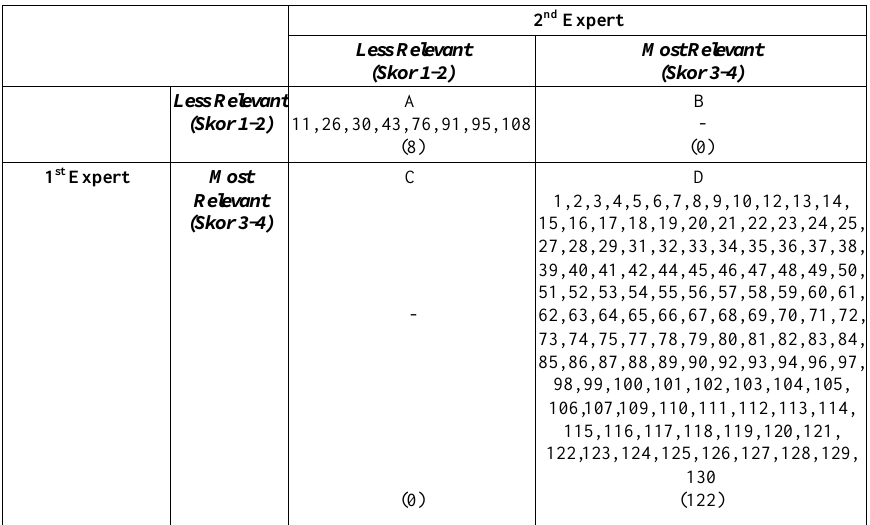
Table 6. Cross Tabulation Data from Tri Kaya Parisudha-Based Countenance Evaluation In- strument Test Results which were conducted by Two Experts 2 nd Expert Less Relevant Most Relevant (Skor 1-2) (Skor